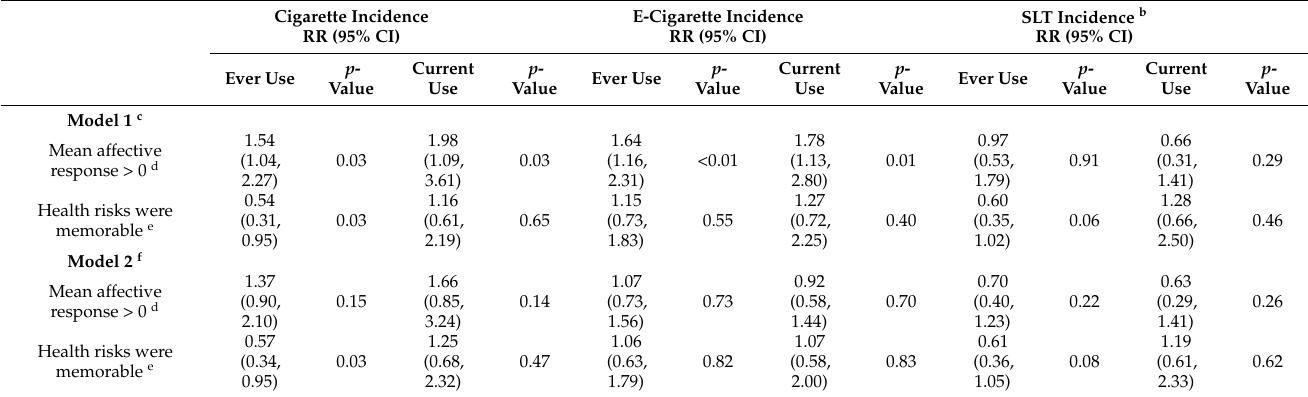
Table 3. Associations between cognitive and affective responses to tobacco advertisements and tobacco use incidence over four years of follow-up a